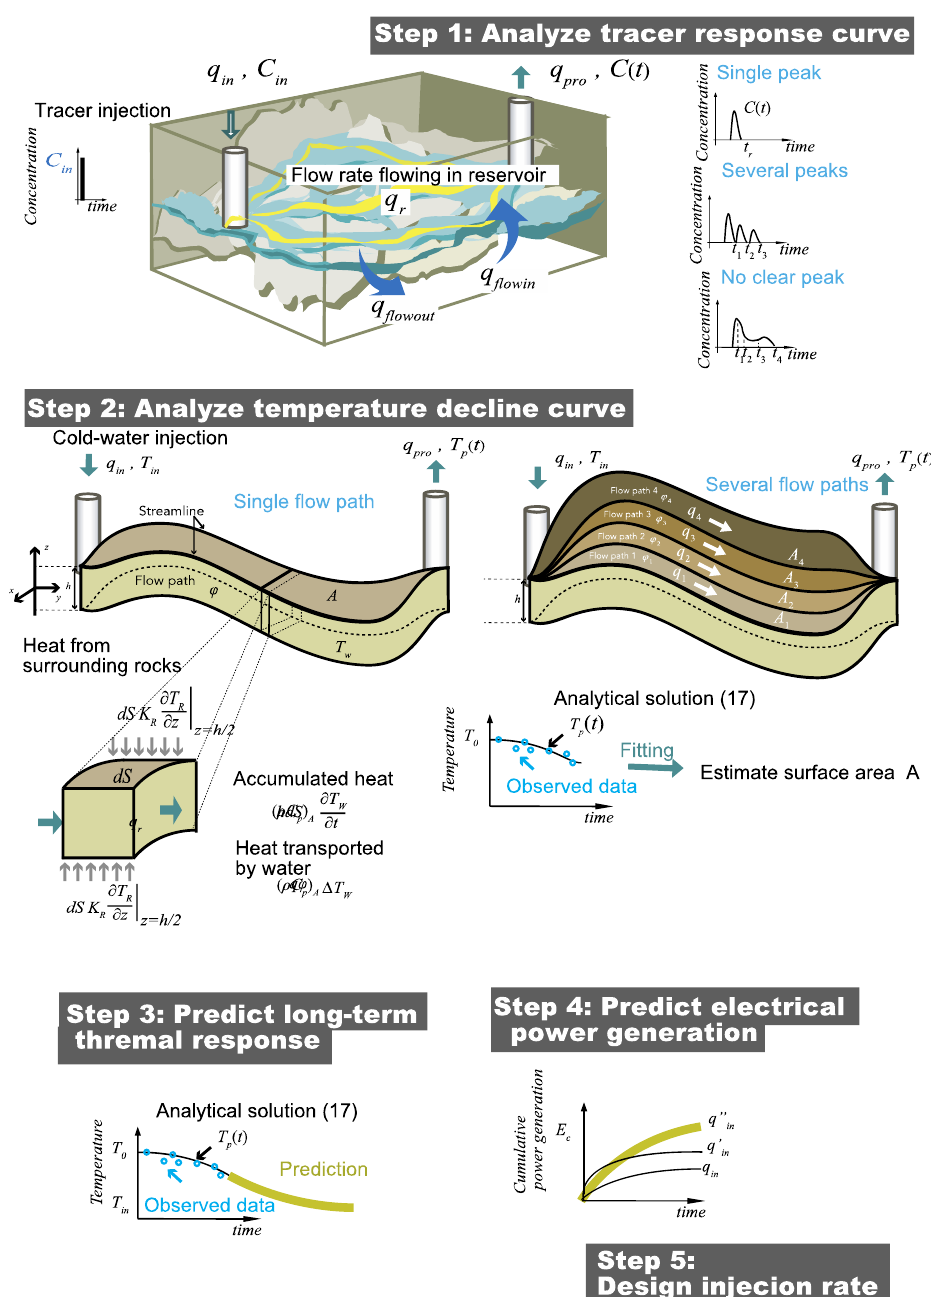
Figure 1. Workflow of procedure for estimating fracture surface area and predicting temperature decline and future power decline and future power generation.